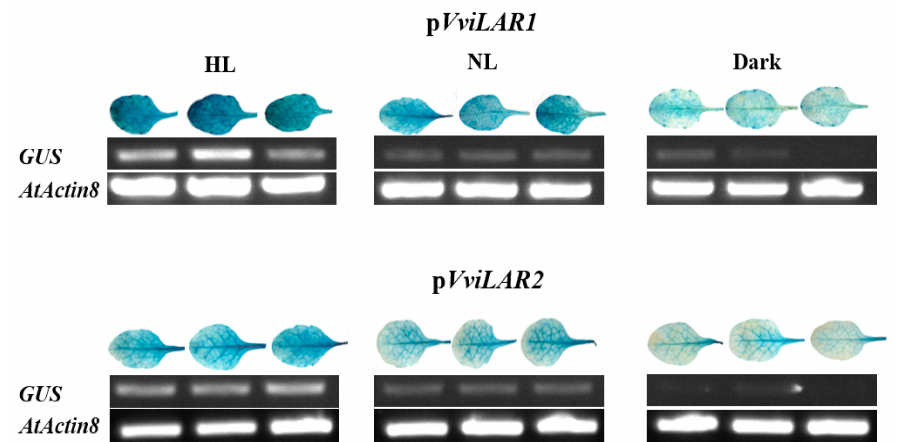
Figure 6. Histochemical GUS staining and expression levels of reporter gene GUS in transgenic Arabidopsis leaves with promoter- GUS fusion vectors under different light intensity treatments. HL: the Arabidopsis treated under high light. NL: the Arabidopsis treated under control condition. In each treatment, the left, middle, and right leaf came from different lines of transgenic Arabidopsis carrying p VviLAR1::GUS or p VviLAR2::GUS , respectively. AtActin8 was used as a control for the semiquantitative reverse transcription PCR (SqRT-PCR). Amplified products were electrophoresed on 1.5%( w / v ) agarose gels.